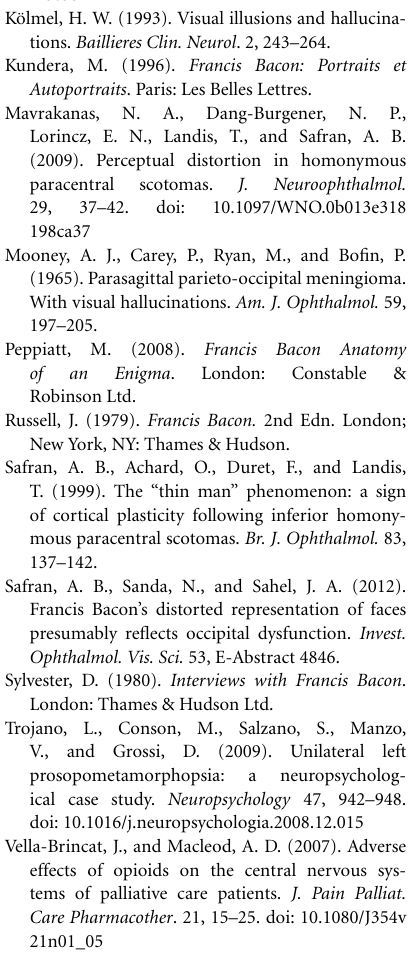
Bacon’s portraits increased in forms and